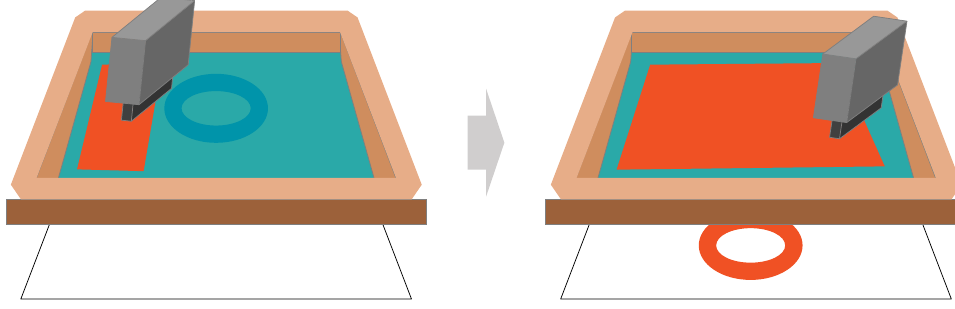
Figure 3. Silkscreen printing method.